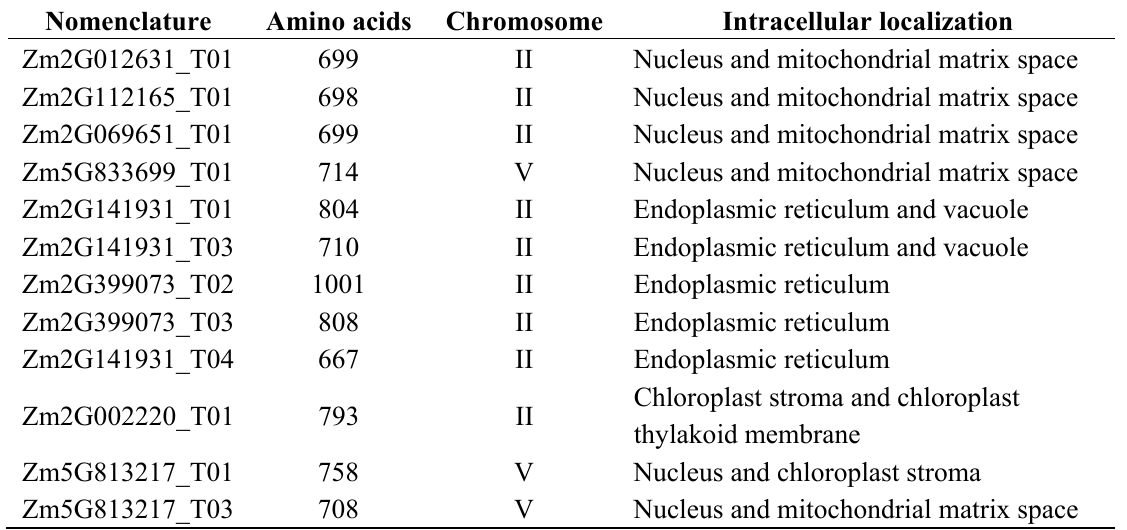
Table 5. Zea mays Hsp90